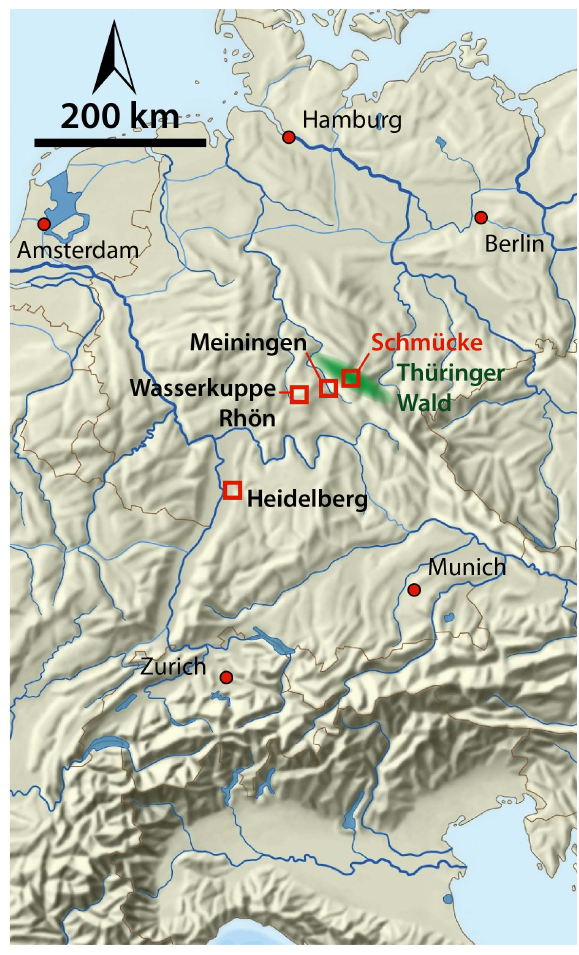
Fig. 1. Location map including the sample collection site Schm¨ucke (red square), the low mountain range Th¨uringer Wald (green area), Meiningen (red square, where the DWD launches its meteorolog- ical soundings), the closest GNIP station Wasserkuppe Rh¨on (red square) and Heidelberg (where Jacob and Sonntag (1990) collected the water vapor samples). The map is based on ”Atlas der Schweiz“ (Hurni,